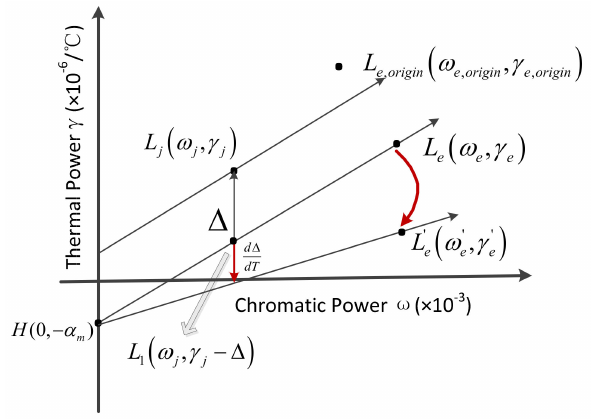
Figure 3. Achromatic and athermal conditions on an athermal map when the offset changes with